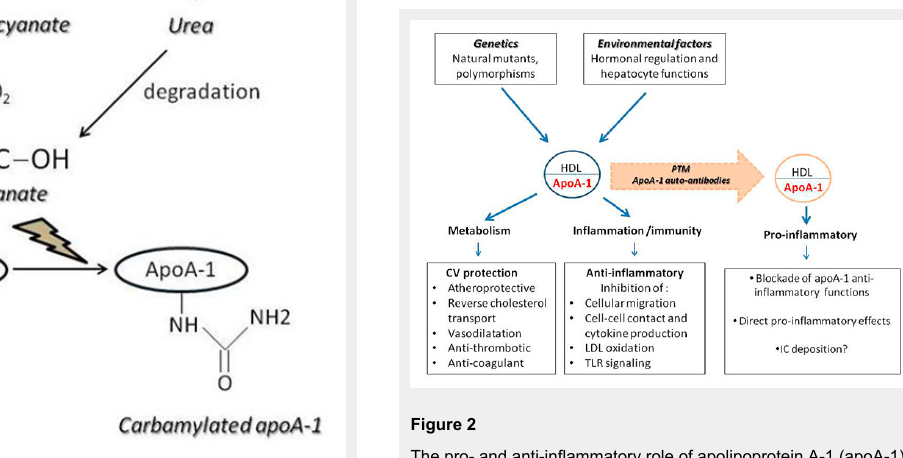
The pro- and anti-inflammatory role of apolipoprotein A-1 (apoA-1) / high-density lipoprotein (LDL). CV = cardiovascular; IC = immune complexes; LDL = low-density lipoprotein; PTM = post-translational modifications; TLR = Toll-like receptor.